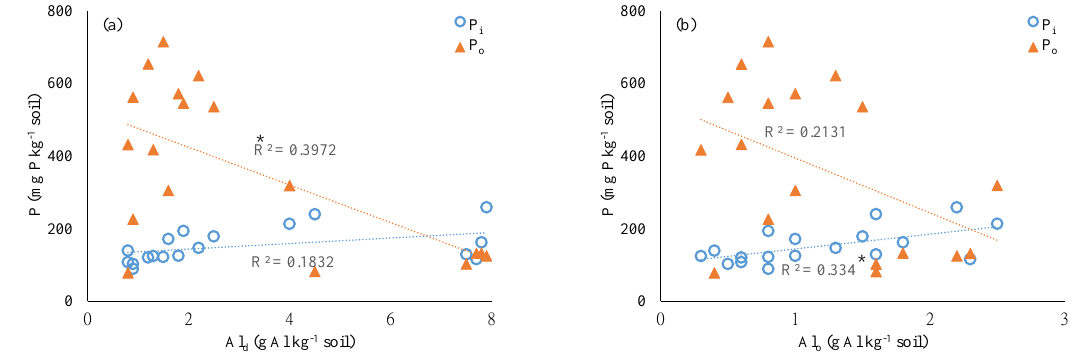
Figure 2. Correlations of contents of P i and P o with Al d ( a ) and Al o ( b ) in the pedon samples collected from the three sampling sites. * Statistically significant at p < 0.05.